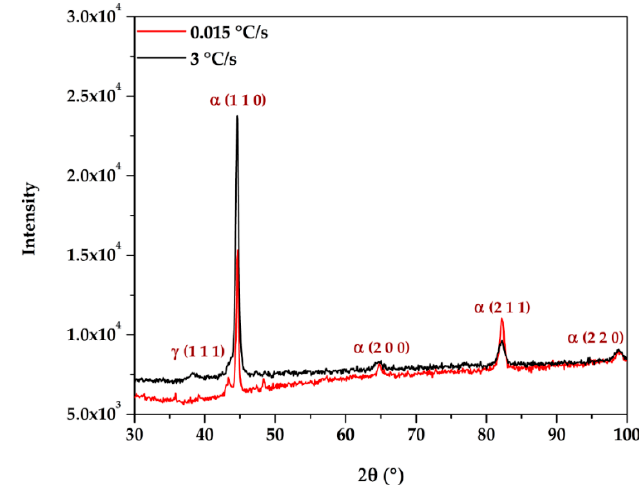
Figure 18. X-ray diffraction for two cooling rates, 0.015 and 3 °C/s. Table 4. Comparison between the volume fractions of retained austenite ( (cid:2011) (cid:3019) ) . Cooling Rate (°C/s)